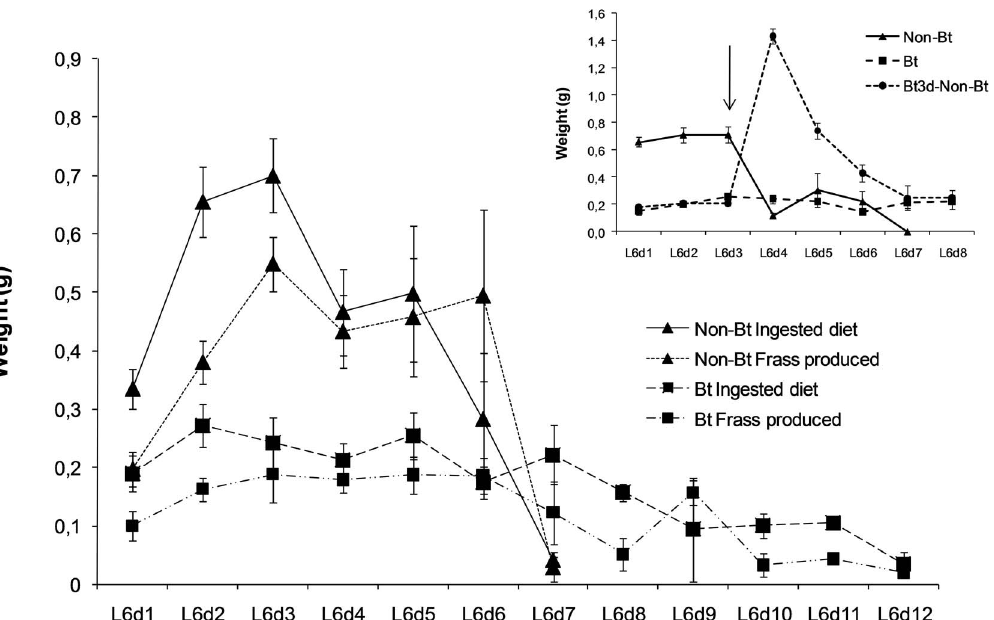
Figure 1. Feeding behaviour, daily mean ( ± SE) of ingested diet (g) and frass produced (g) of the L 6 larvae of of Helicoverpaarmigera fed on the Bt or non-Bt diet. Inset compares the daily ingested diet of the larvae fed for the whole last instar on the Bt or non-Bt diet with the ingested food of the larvae fed on the Bt diet for three days and then on the non-Bt diet for the rest of the instar. Arrow in the inset indicate the day the lavae were changed from the Bt to non-Bt diet.